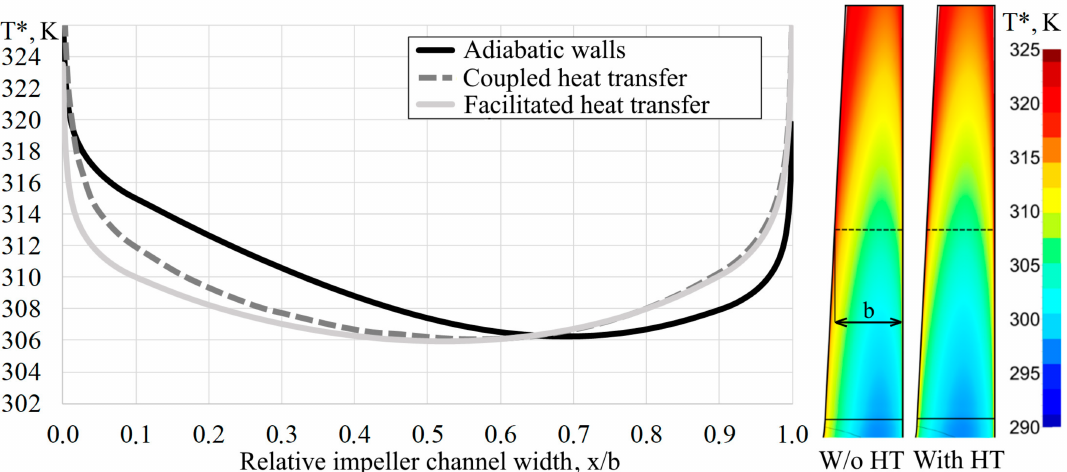
Figure 5. Temperature profiles in the average cross-section of the impeller blade in diameter for three variants of flow part heat